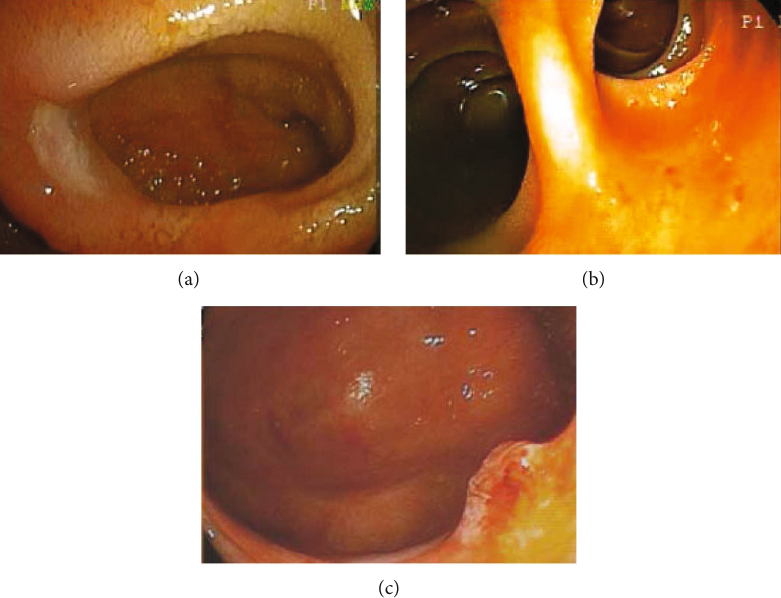
Figure 2: Endoscopy showing an ulcer in the margin of Meckel ’ s diverticulum (a); endoscopy showing several erosions in the ori fi ce of Meckel ’ s diverticulum (b); endoscopy showing a protruding vessel in the margin of Meckel ’ s diverticulum